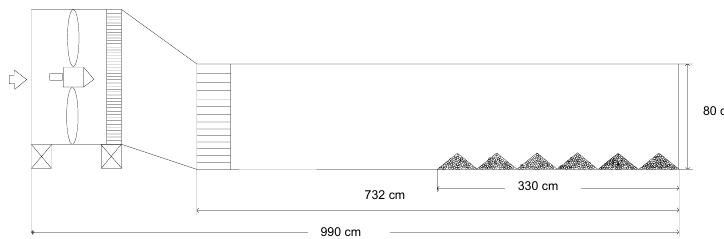
Fig. 1. Schematic view of the wind tunnel and location of the tested